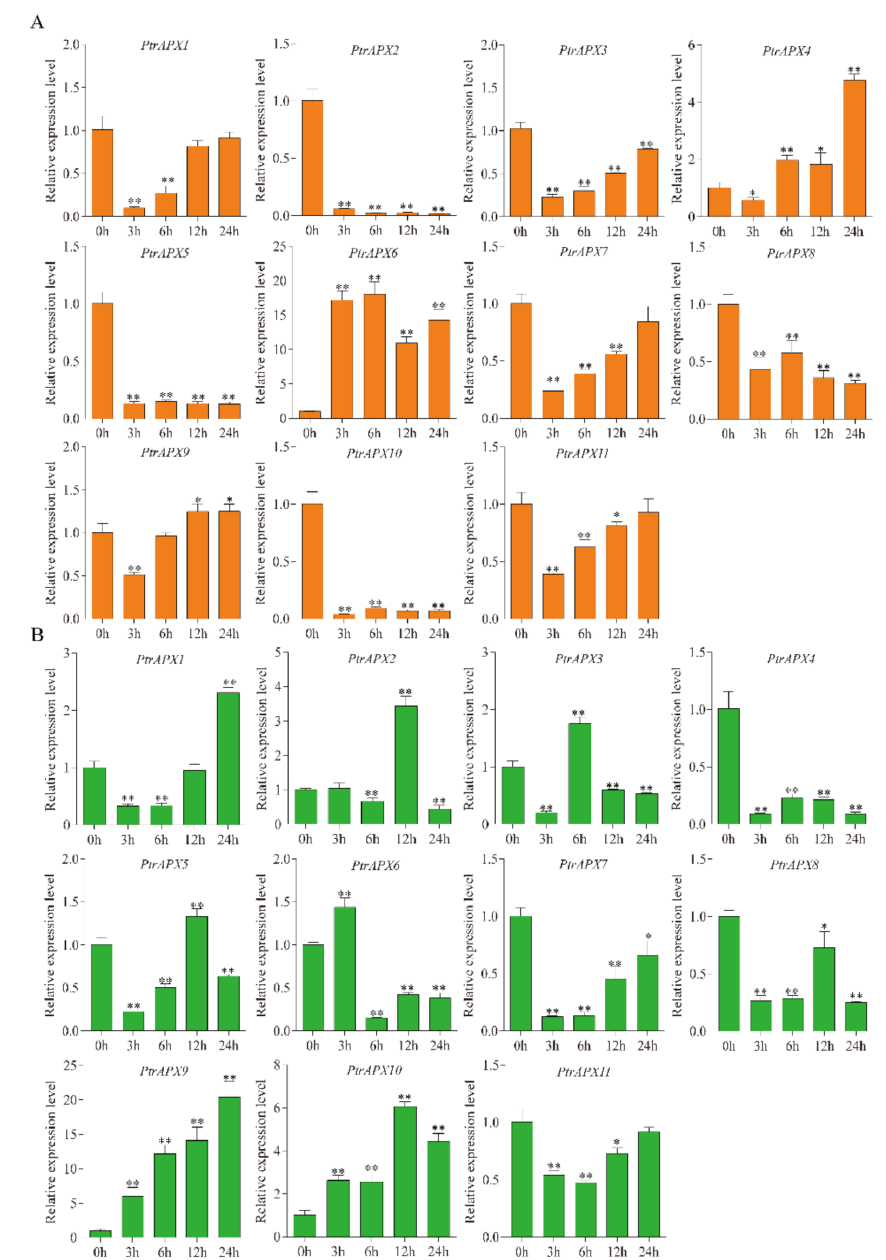
Figure 9. Relative expression level of PtrAPX genes under 150 mM NaCl treatment estimated by RT-qPCR. The expression pattern of PtrAPX genes in roots ( A ) and leaves ( B ) is shown. Error bars represent the standard deviations from three biological replicates. The x-axis represents time points after NaCl treatment. Asterisks indicate stress treatment groups that showed a significant difference in transcript abundance compared with the control group (* 0.01< p < 0.05, ** p <